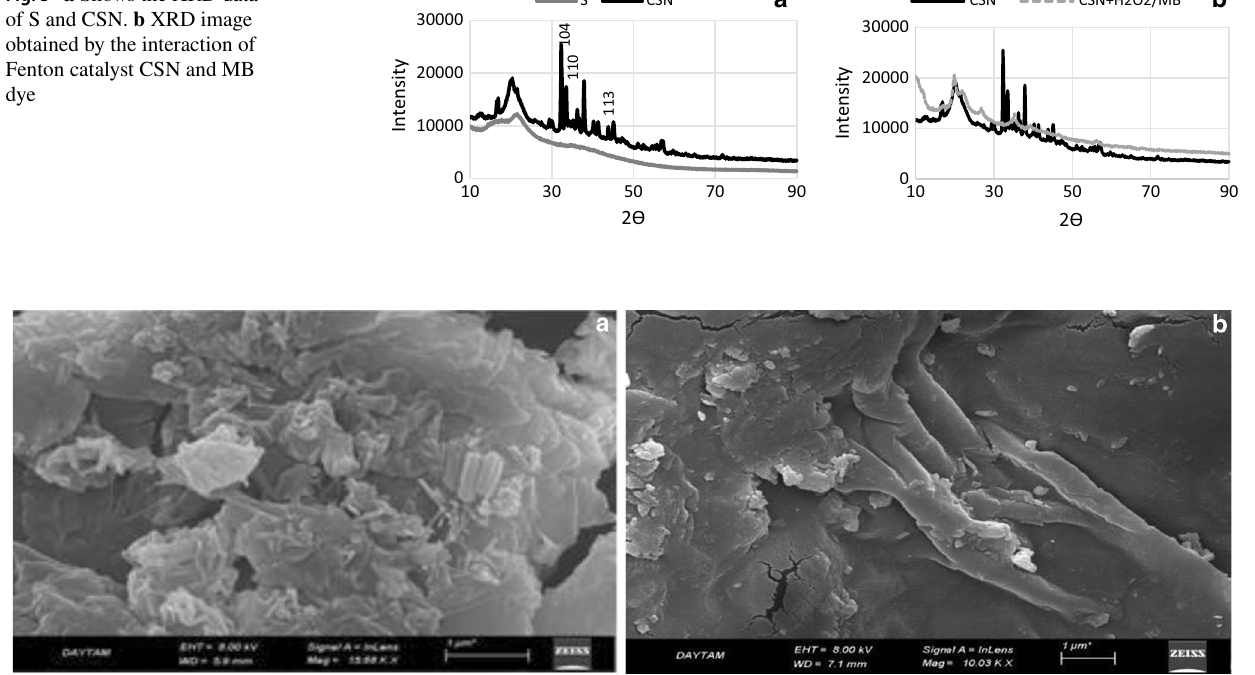
Fig. 6 a Shows the SEM analysis of CSN. b SEM image obtained by interaction of CS dye Fenton catalyst and MB